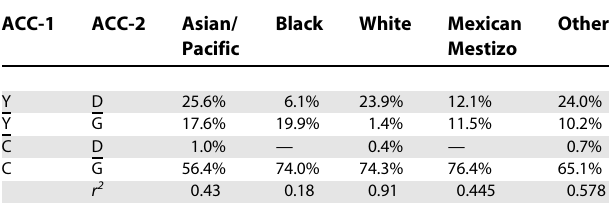
Table 4. Analysis of ACC-1/ACC-2